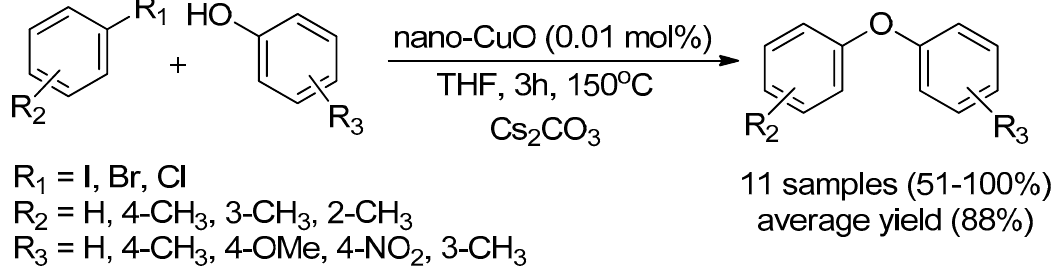
Scheme 8. Formation of diphenyl ethers in the presence of CuO nano cube.